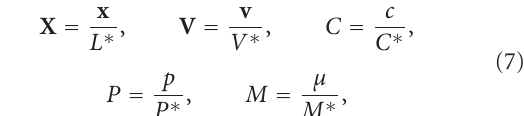
where ρ represents the SF density, D = 1 / 2( ∇ v + ( ∇ v ) T )